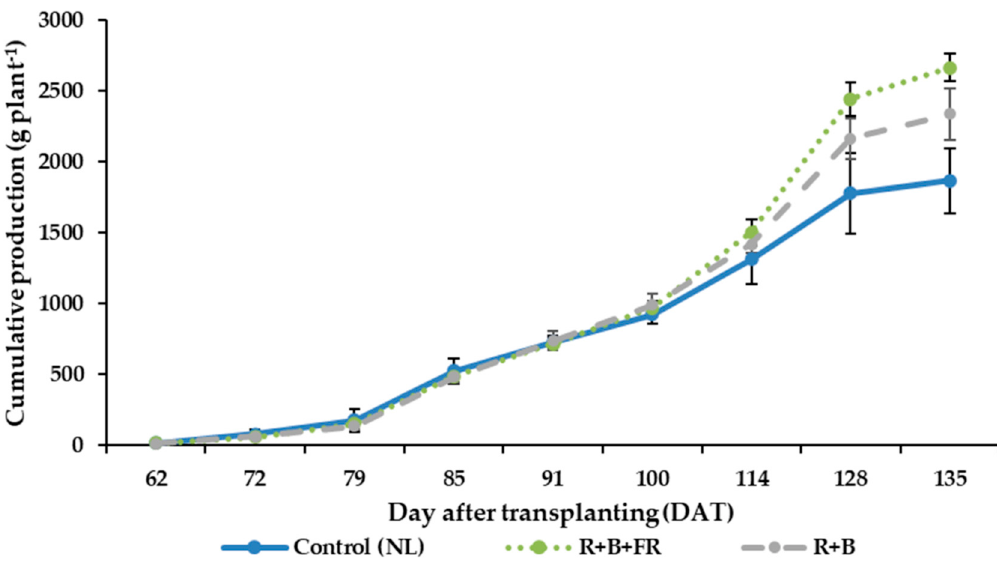
Figure 4. Cumulative production, in g plant − 1 , by plants grown under control (NL), R + B + FR and R + B light conditions. Values are average of three replications. Vertical bars represent ± standard deviation of mean values.